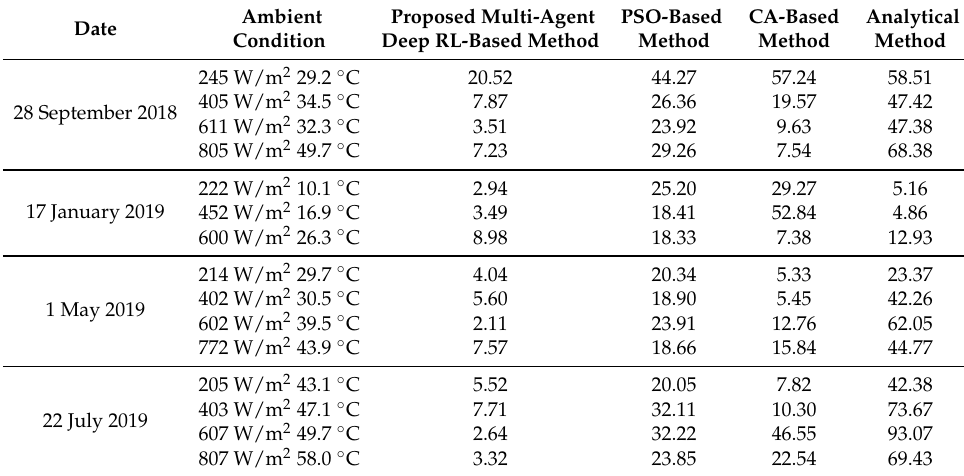
Table 5. Comparison of MAPE (%) for different methods in Figure 7.